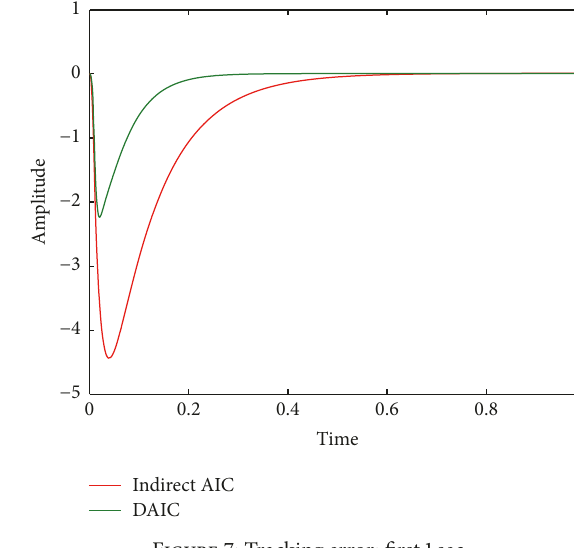
Figure 5: Tracking desired output: first 1sec.